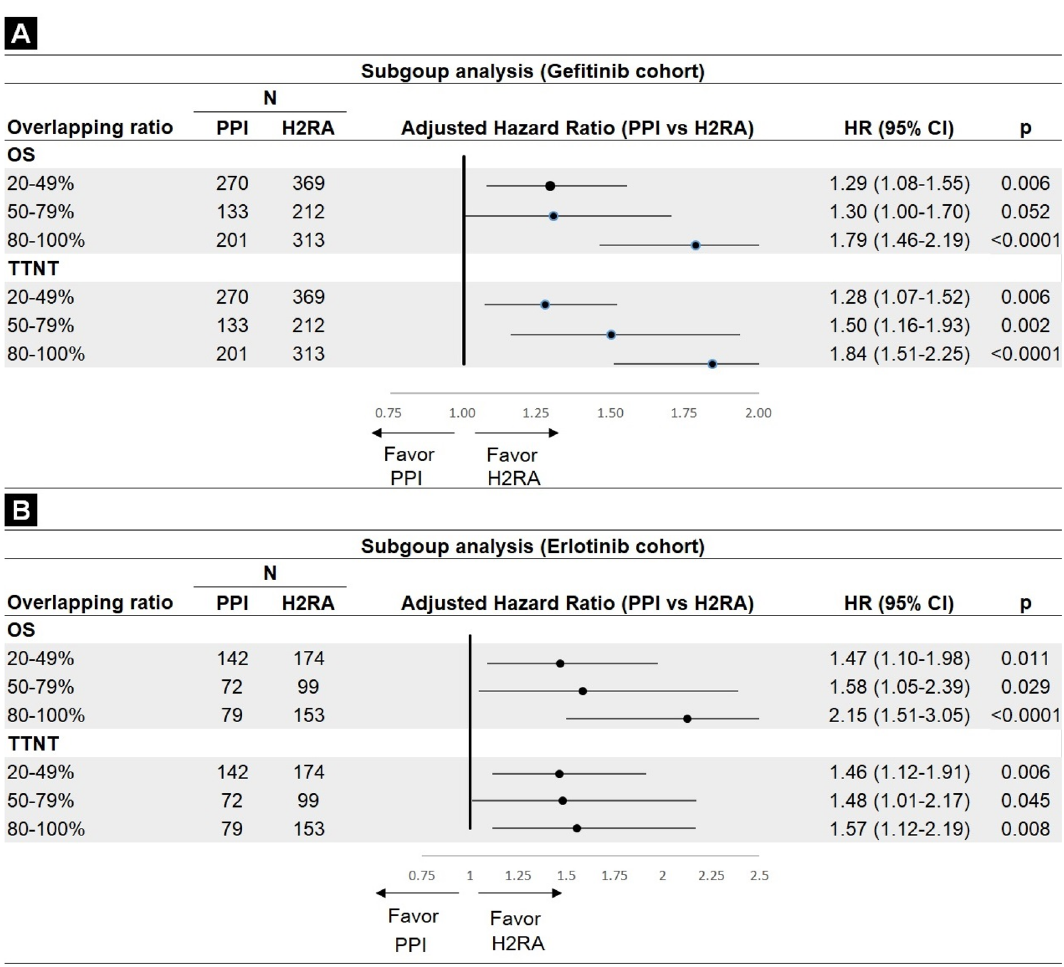
Figure 3. Subgroup analysis: effects of different overlapping ratios in overall survival (OS) and time to next treatment (TTNT) between PPI and H2RA groups. ( A ) gefitinib cohort and ( B ) erlotinib